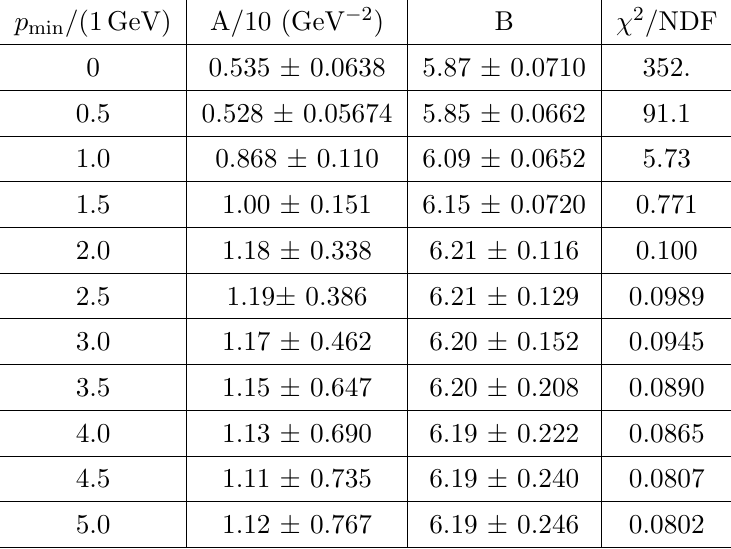
Table 6. Fitted values of parameters in eq. (E.2) for the ALICE dataset at p s = 5 : 02 TeV in the (cid:17) < 0 : 3 bin [95]. j j